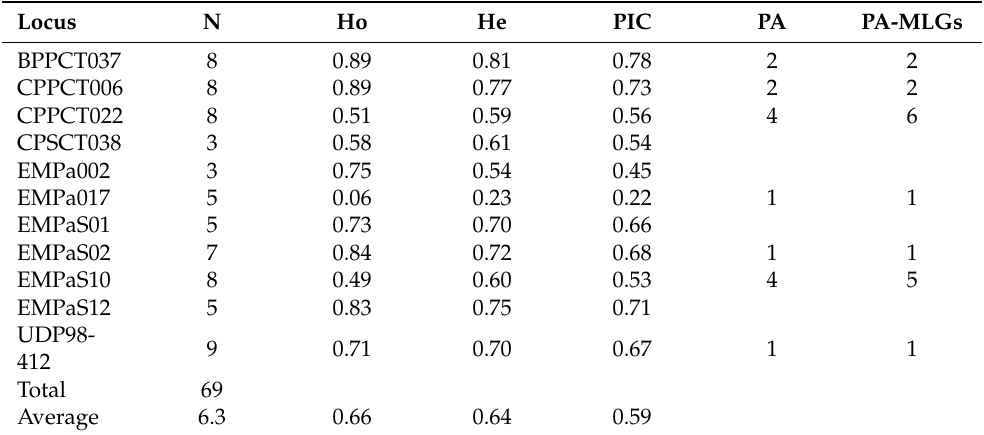
Table 4. Genetic parameters detected for SSR markers used to study autochthonous Austrian sweet cherry accessions and international